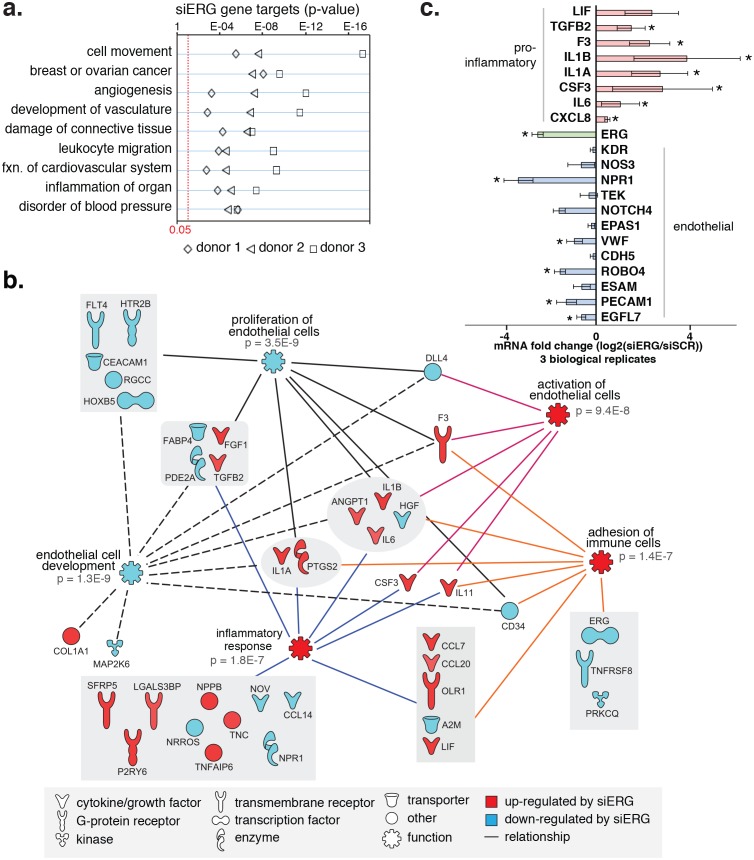
ERG knockdown elicits a pro-inflammatory gene profile in HAECs.(a) Genes up-regulated by ERG knockdown (≥4 fold, 5% FDR) were enriched in the indicated functional pathways using Ingenuity Pathway Analysis (IPA). Results are from three experiments using cells from different HAEC donors. ERG levels are shown in c. (b) A network of molecules regulated by ERG knockdown (red = up-regulated; blue = down-regulated) with membership (lines) to five functional processes. The predicted state of the functional processes is shown by color (activation in red; and inhibited in blue). Network analysis was performed using IPA and p-values correspond to pathway enrichments. (c) The log2 fold change caused by siERG knock-down is shown for endothelial-specific genes (blue) and pro-inflammatory genes (pink). Plotted is mean ± SD of fold changes measured in three HAEC donors. Per donor/gene effects are included in Figure 5—figure supplement 1. Asterisk indicates p-value<0.05 from a paired t-test of siERG to siSCR values across three donors. More related data in Figure 4—figure supplements 1 and 2.